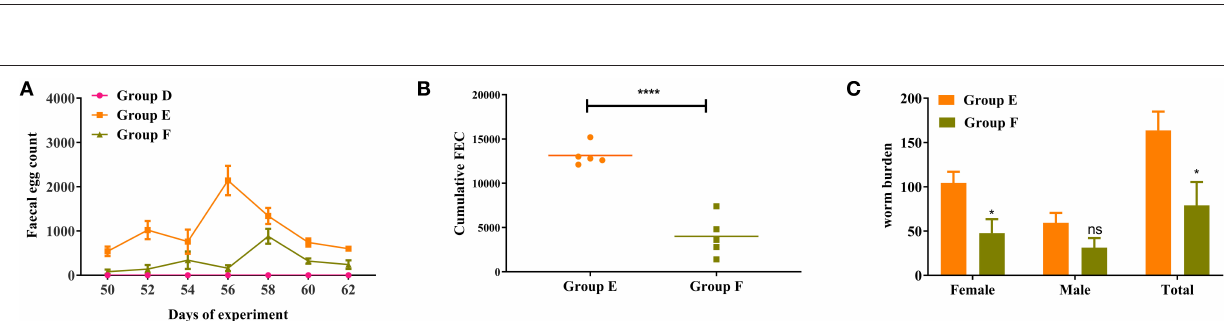
FIGURE 4 | Hemoglobin levels in trial 1. Group A, unchallenged goats; Group B, goats challenged with L3s at day 1; Group C, goats challenged with L3s at day 1 and then immunized by PcAb-rHc8 antibodies at days 2 and 3 post challenge. Hemoglobin (HGB) contents of blood samples were determined. Data are shown as means ± SEM.